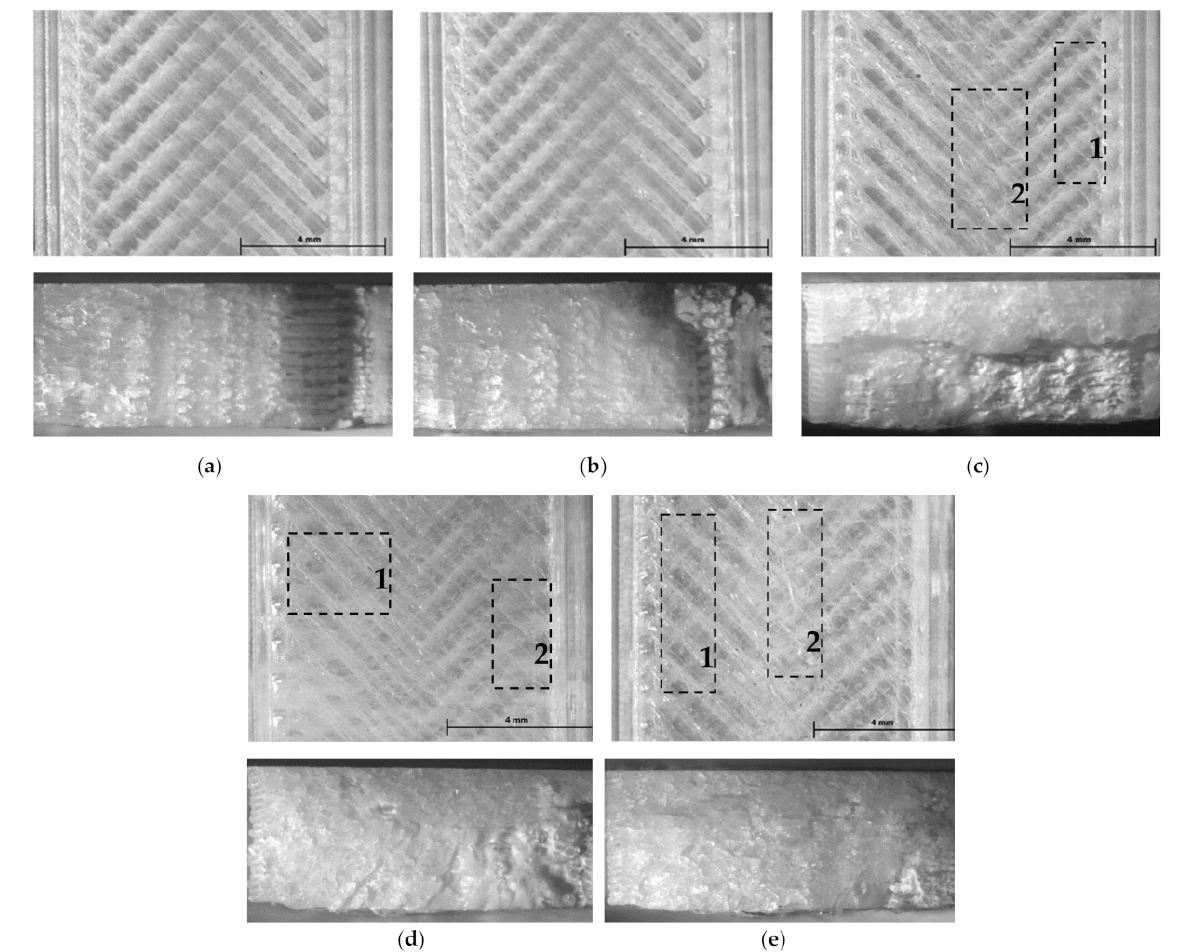
Figure 3. Top view (up) and fractured surface (down) of natural PLA tensile specimens printed at ( a ) 200 ◦ C, ( b ) 210 ◦ C, ( c ) 220 ◦ C, ( d ) 230 ◦ C, ( e ) 240 ◦